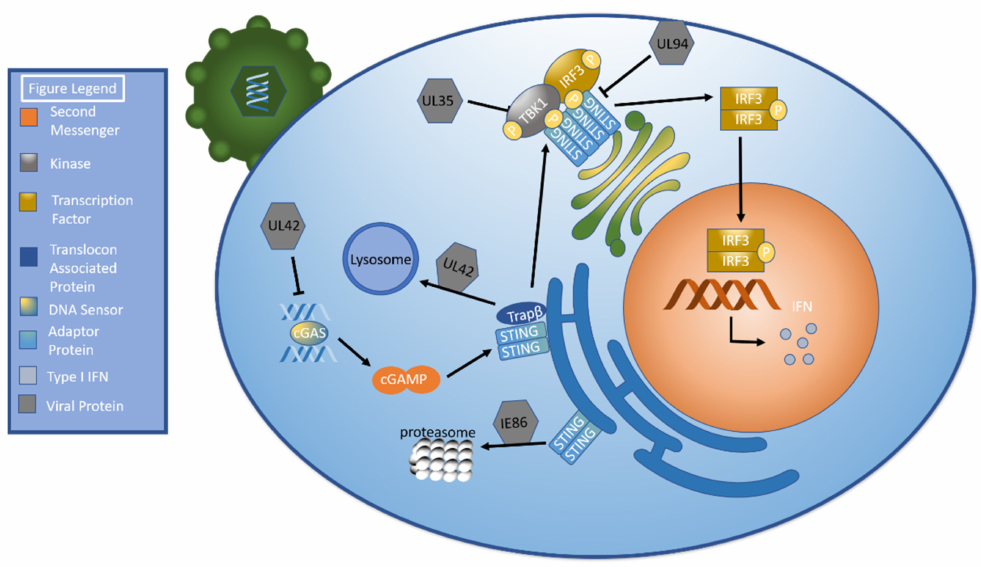
Figure 2. The cGAS-cGAMP-STING Pathway and Human Cytomegalovirus Immunoevasive Meth- ods. The cGAS-cGAMP-STING pathway is activated after cGAS detects abnormal double-stranded DNA in the cytosol. cGAS produces cGAMP, which stimulates the translocation of STING to the golgi, where it oligomerizes. STING recruits TBK1, which then autophosphorylates and phosphorylates STING. STING recruits IRF3 to create a STING/TBK1/IRF3 complex. TBK1 then phosphorylates IRF3, which dissociates from the complex, dimerizes, and translocates to the nucleus. Once there, it stimulates interferon transcription. UL42 inhibits cGAS and promotes TRAP β degradation via lysosomes. UL94 inhibits STING dimerization and prevents STING from recruiting TBK1. UL35 inhibits TBK1. IE86 facilitates the proteasomal degradation of